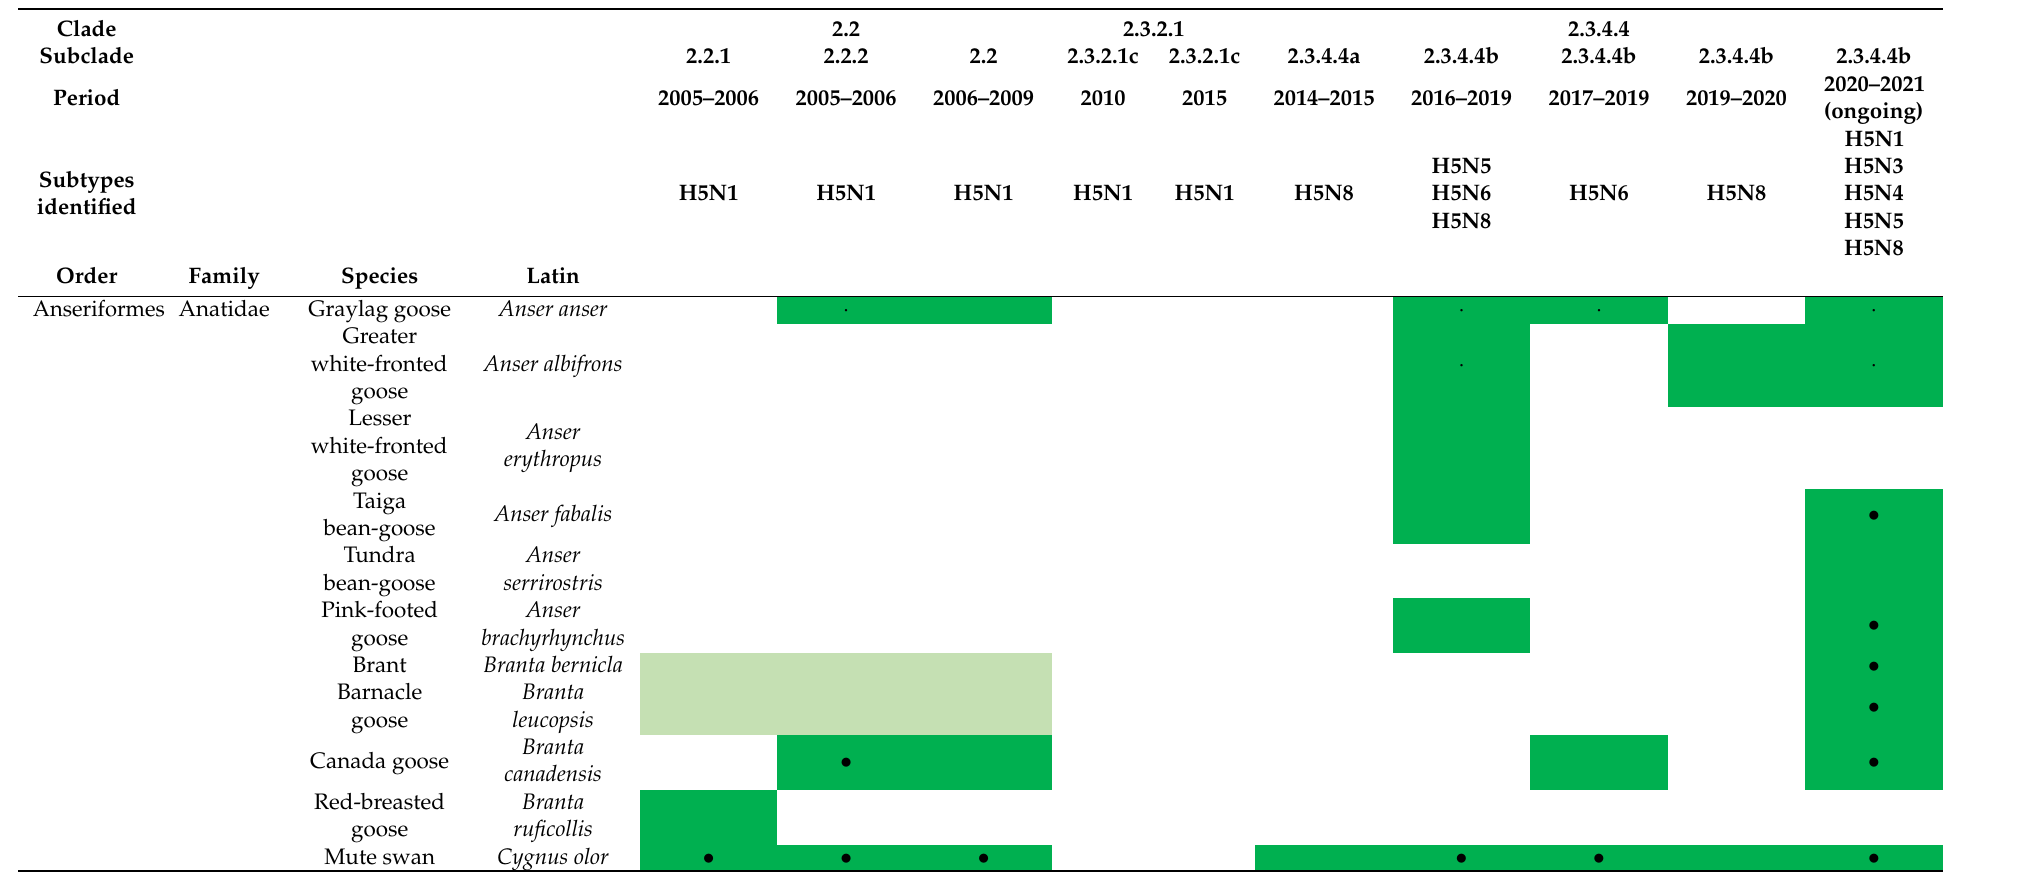
Table 2. Highly pathogenic avian influenza viruses of the GsGd lineage detected in wild birds in Europe, 2005–2020. Blue, viruses detected in at least one apparently healthy individual of the wild bird species; green, viruses detected in wild bird species; light green, clade 2.2 viruses detected in wild birds and subclade unknown. ( • ) indicates species–subclade combinations reported in more than one European country. References used